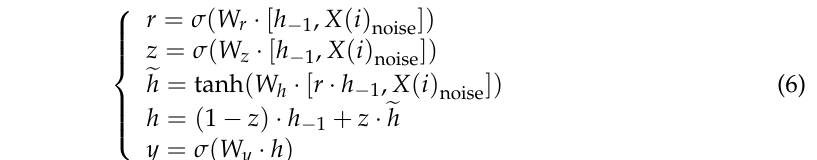
Figure 5. GAE Model.